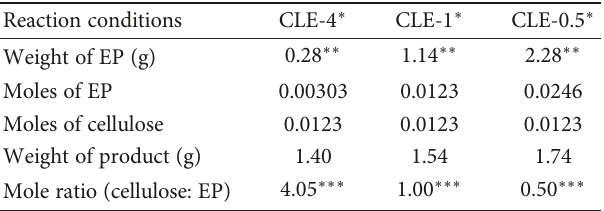
Table 1: Synthetic ratios of cellulose and epichlorohydrin (EP) for cross-linked